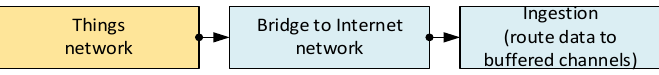
Figure 1. General structure of data pipelines in fault diagnosis.